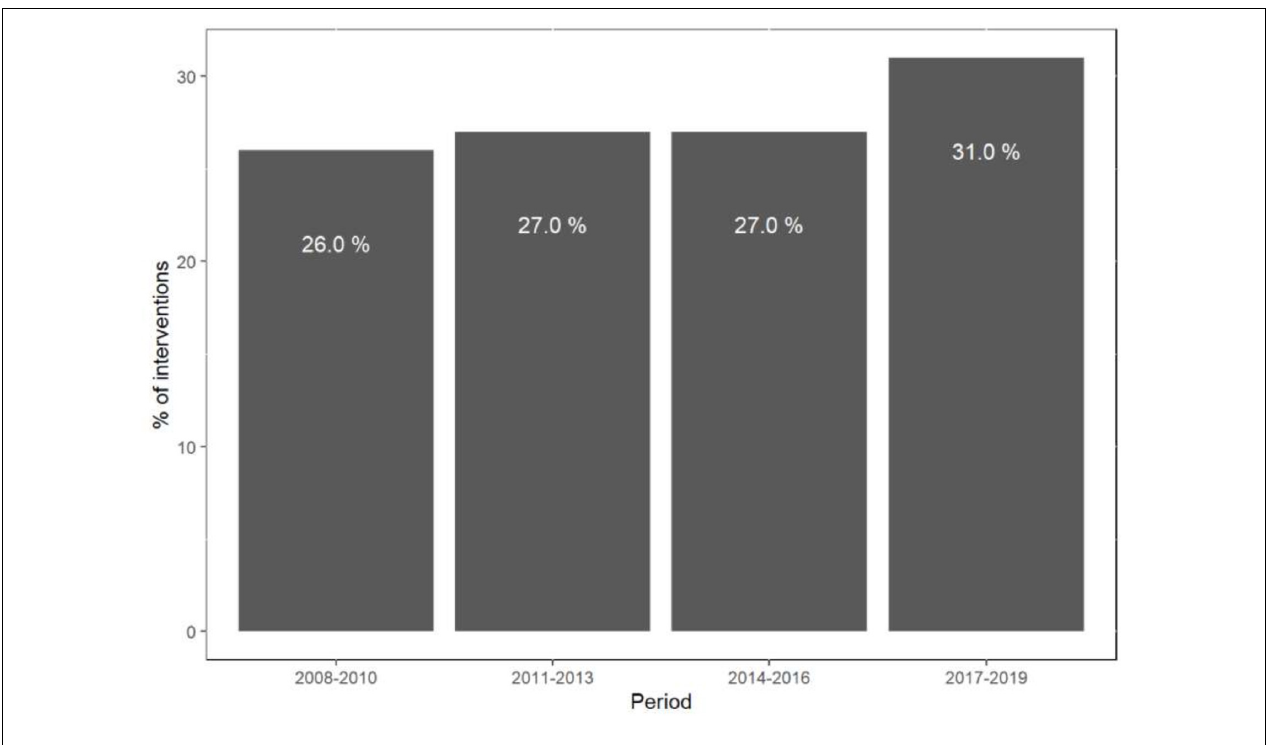
FIGURE 1 | Rate of complex PCI (percent of total interventions) per time period.